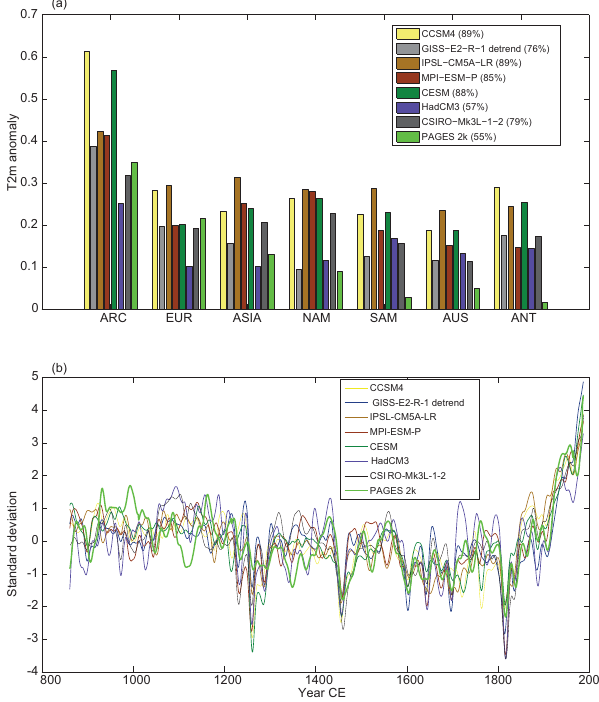
Figure 6. (a) Leading EOFs of the near-surface temperature sim- ulated by each CMIP5/PMIP3 model and reconstructions over the full period 850–2004 CE. The EOF analysis is based on the co- variance matrix with respect to temperature anomalies for the pre- industrial period 850–1850 CE. Values in parentheses correspond to the amount of variance represented by the leading EOF. (b) Time series of the principal components (PCs) corresponding to the lead- ing EOF for the PMIP3 simulations and PAGES 2k reconstructions. The time series were filtered with a 23-year Hamming filter and were linearly detrended before the covariance matrix was calcu- lated. The PC time series are shown as standardized anomalies from the average over the full period 850–2004 CE. Positive PC values correspond to positive temperature anomalies in the respective re- gions. Results for single-member realizations and the pre-industrial period are presented in the Figs. S7 and S8,